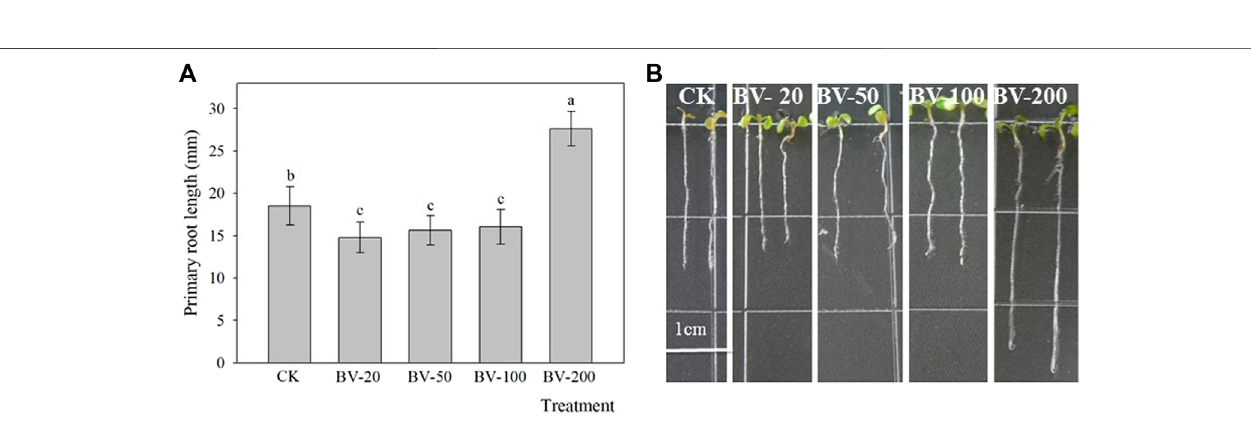
FIGURE 2 | Effects of different concentrations of BV nanomaterial on the primary root length of Arabidopsis. Bar of (A) was standard error. Scale bar (cid:2) 1 cm. CK, BV-20, BV-50, BV-100, and BV-200 of (A and B) were added to the MS medium with 0, 20, 50, 100, and 200 μ g ml − 1 of BV, respectively. N (cid:2) 30. Different lowercase letters above the bar of (A) indicate that there were signi fi cant differences among the treatments at p < 0.05.